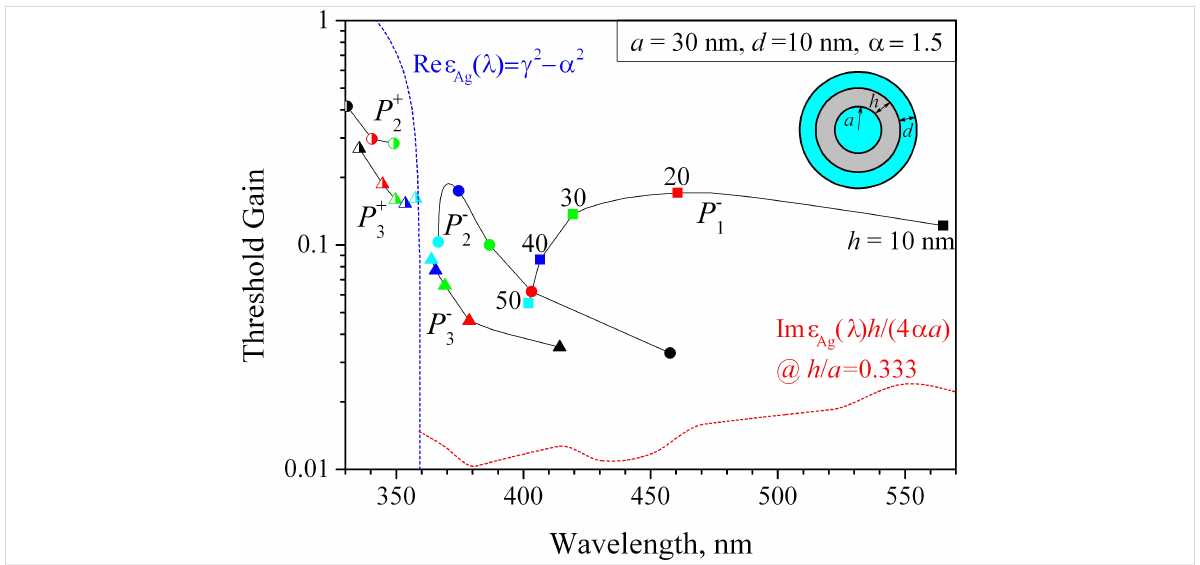
Figure 5: The trajectories of the eigenvalues of lasing modes on the plane ( λ , γ ) for plasmonic silver nanotube laser with an active core radius a = 30 nm and an active shell thickness d = 10 nm. The tube thickness varies from 10 to 50 nm as marked on the trajectories. The blue dashed line indicates the wavelength at which Re ε met ( λ ) = −α 2 + γ 2 (if γ = 0 then this is 359 nm [33]). The red dashed line indicates the lower-bound estimate (Equation 16) for the modes of silver tube with h = a